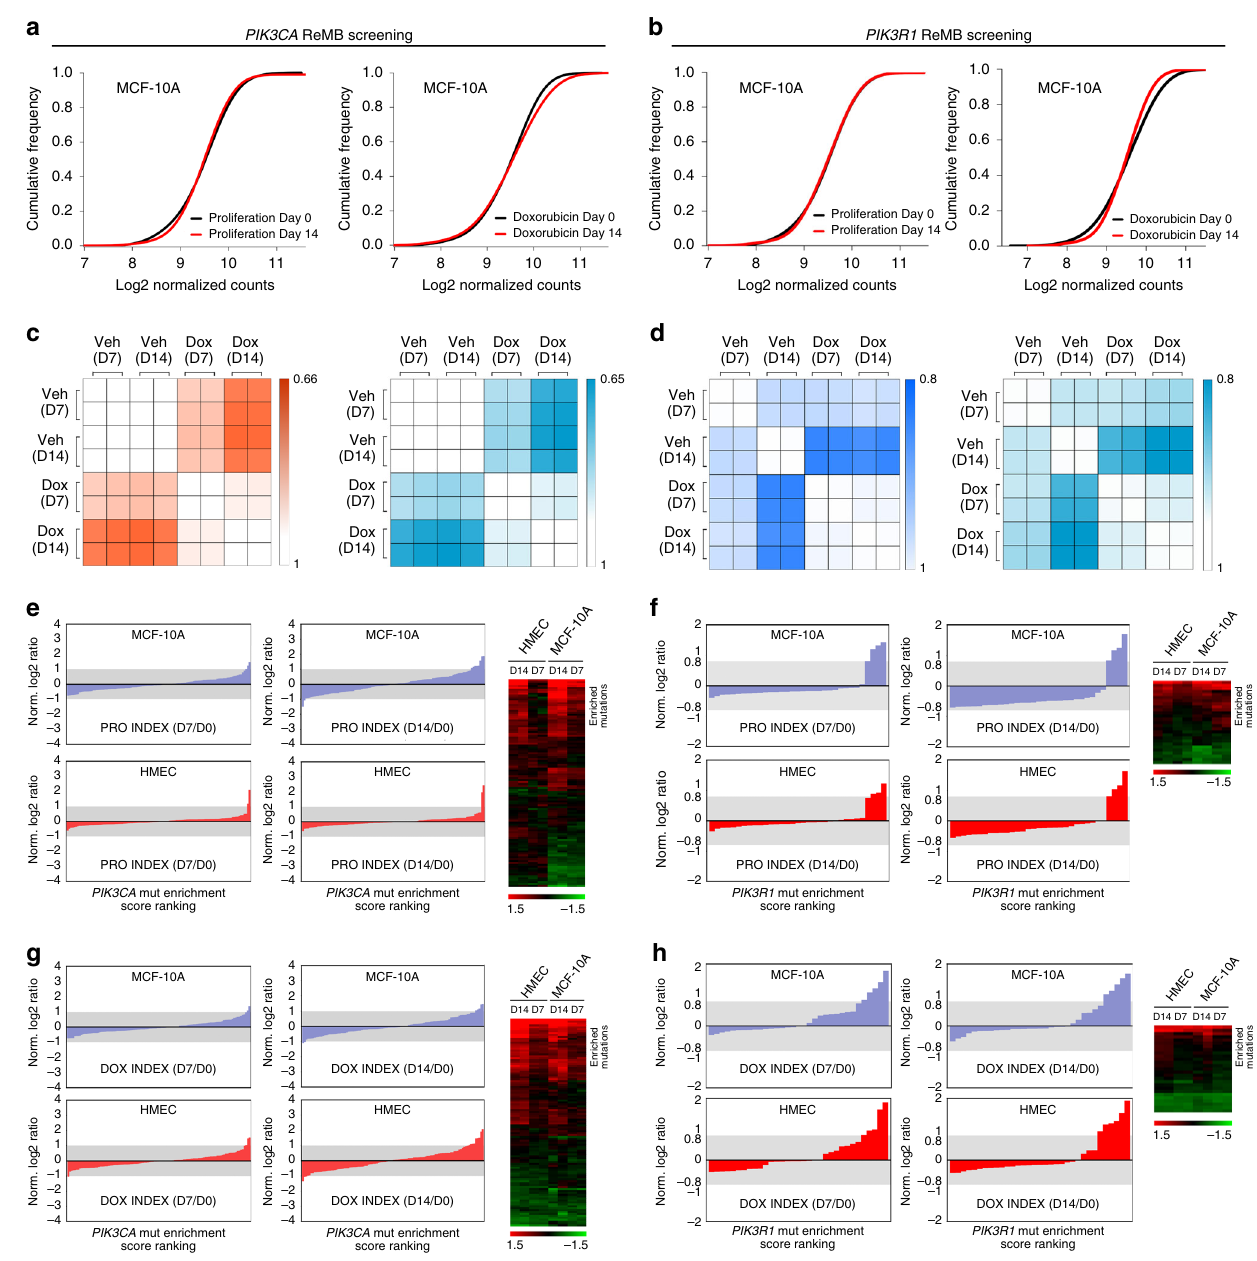
Fig. 3 ReMB library screening for proliferation- and doxorubicin resistance-associated mutations of PIK3CA and PIK3R1 in MCF-10A and HEMC cells. a , b Cumulative frequency of PIK3CA and PIK3R1 mutations in the proliferation and doxorubicin response assays on Day 0 and Day 14 after transduction. c , d Rank correlations of normalized read counts between biological replicates and treatment conditions in MCF-10A and HMEC cells (Veh vehicle, Dox doxorubicin). Pearson ’ s correlation coef fi cient was used for comparisons. e – h Waterfall chart showing the enrichment of mutations in the indicated assays normalized to Day 0 read counts in MCF-10A and HMEC cells. For each cell line, the mutations were ranked on the basis of the mean normalized log 2 (Day 14/Day 0) ratios and log 2 (Day 7/Day 0) ratios of the read counts. The shaded rectangle indicates a log 2 ratio range between − 1 and 1. The clustering of the two cell lines reveals the enriched mutations that were consistent in the proliferation and drug response screens. The color scale represents the mean normalized log 2 (Day 14/Day 0) ratios and log 2 (Day 7/Day 0) ratios of the read